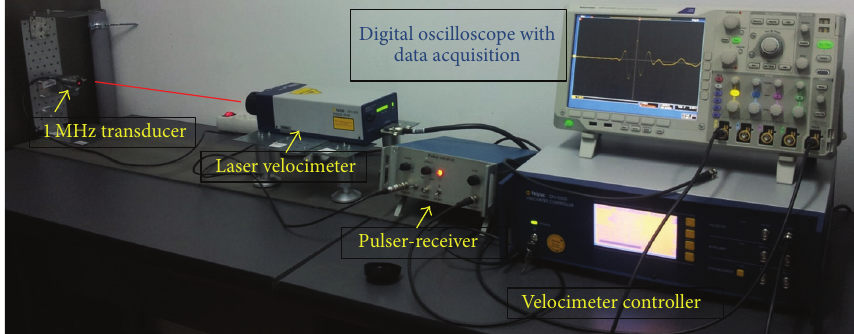
Figure 6: Experimental setup used to measure free response of the ultrasonic transducer.